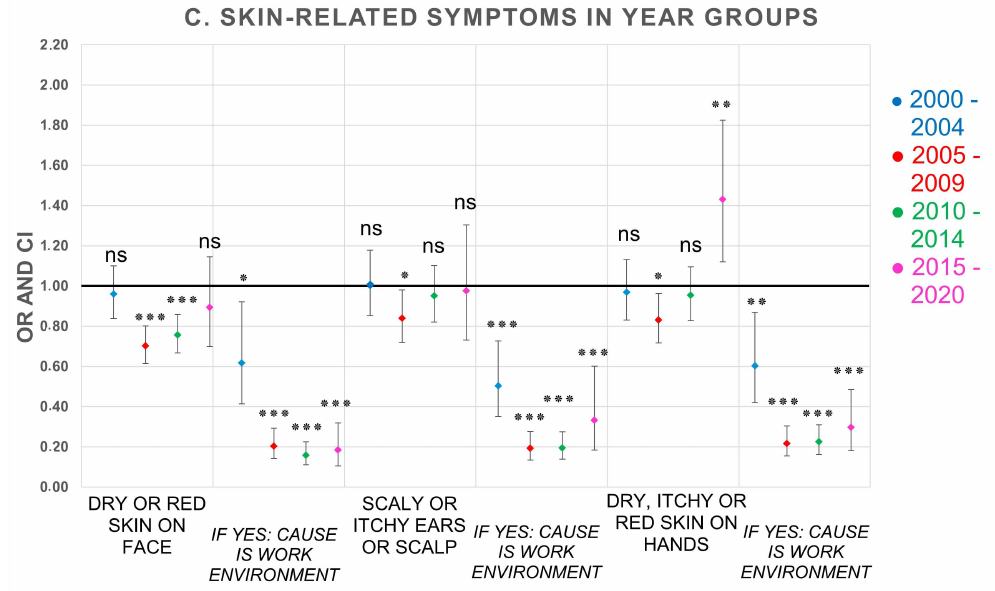
Figure 3. OR and 95% CI of 5-year groups compared to reference group (1995–1999, OR 1) for skin symptoms and perceived causality to the office environment. Logistic regression analyses adjusted for sex and atopy. Number of respondents in each year group: 1995–1999 ( n = 4028); 2000–2004 ( n = 5348); 2005–2009 ( n = 7293); 2010–2014 ( n = 8904); 2015–2020 ( n = 790). OR = odds ratio, CI = confidence interval. p -values: * <0.05; ** ≤ 0.01; *** ≤ 0.001; ns = not